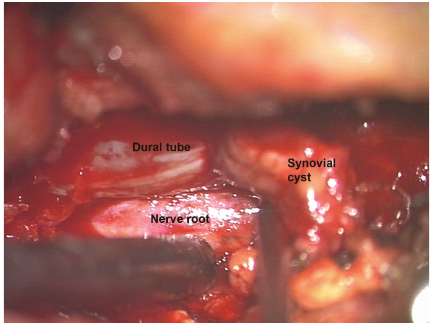
Figure 4: Intraoperative photograph of intraspinal sacral mass